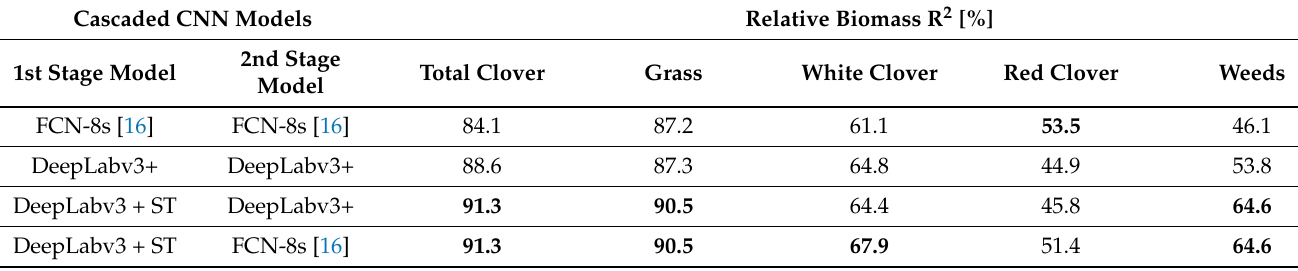
Table 4. Comparison with Skovsen et al. [16] on the same dataset using coefficient of determination between analyzed canopy cover and relative biomass content for each class of species. Contrary to Table 3, this evaluation includes all 915 biomass samples in the comparison to maximize the extent of experimental sites, camera systems, seeded compositions, weather conditions, and seasons. The best result in each category is marked in bold